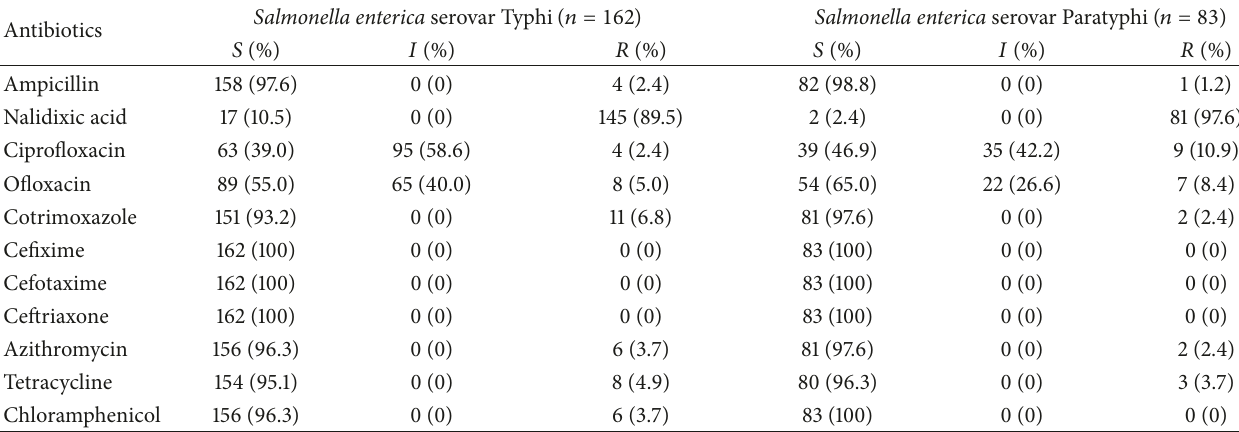
Table 2: Antimicrobial susceptibilities of Salmonella enterica serovars.